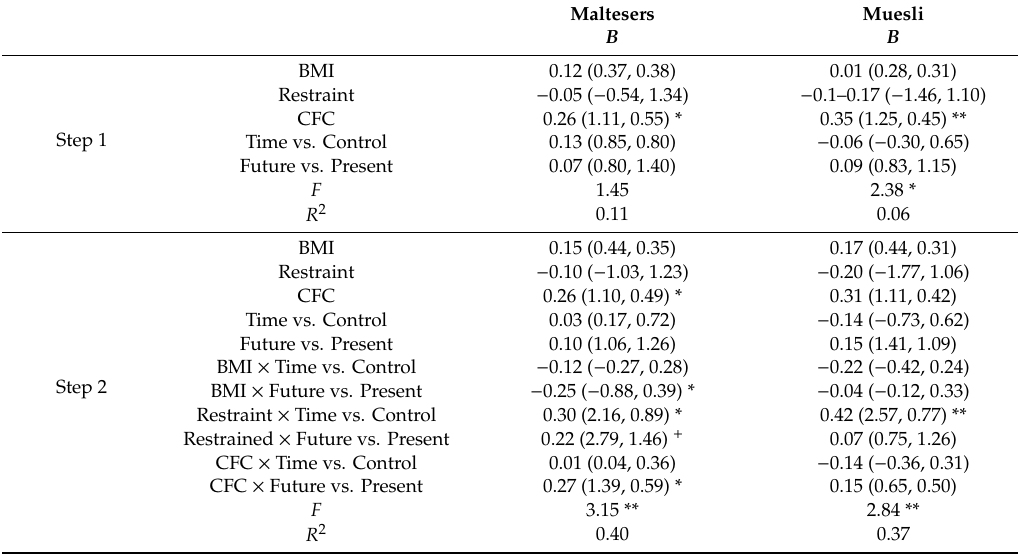
Table 2. Standardized regression coe ffi cients in Experiment 1 for amount of Maltesers and muesli consumed (unstandardized coe ffi cients, standard error in